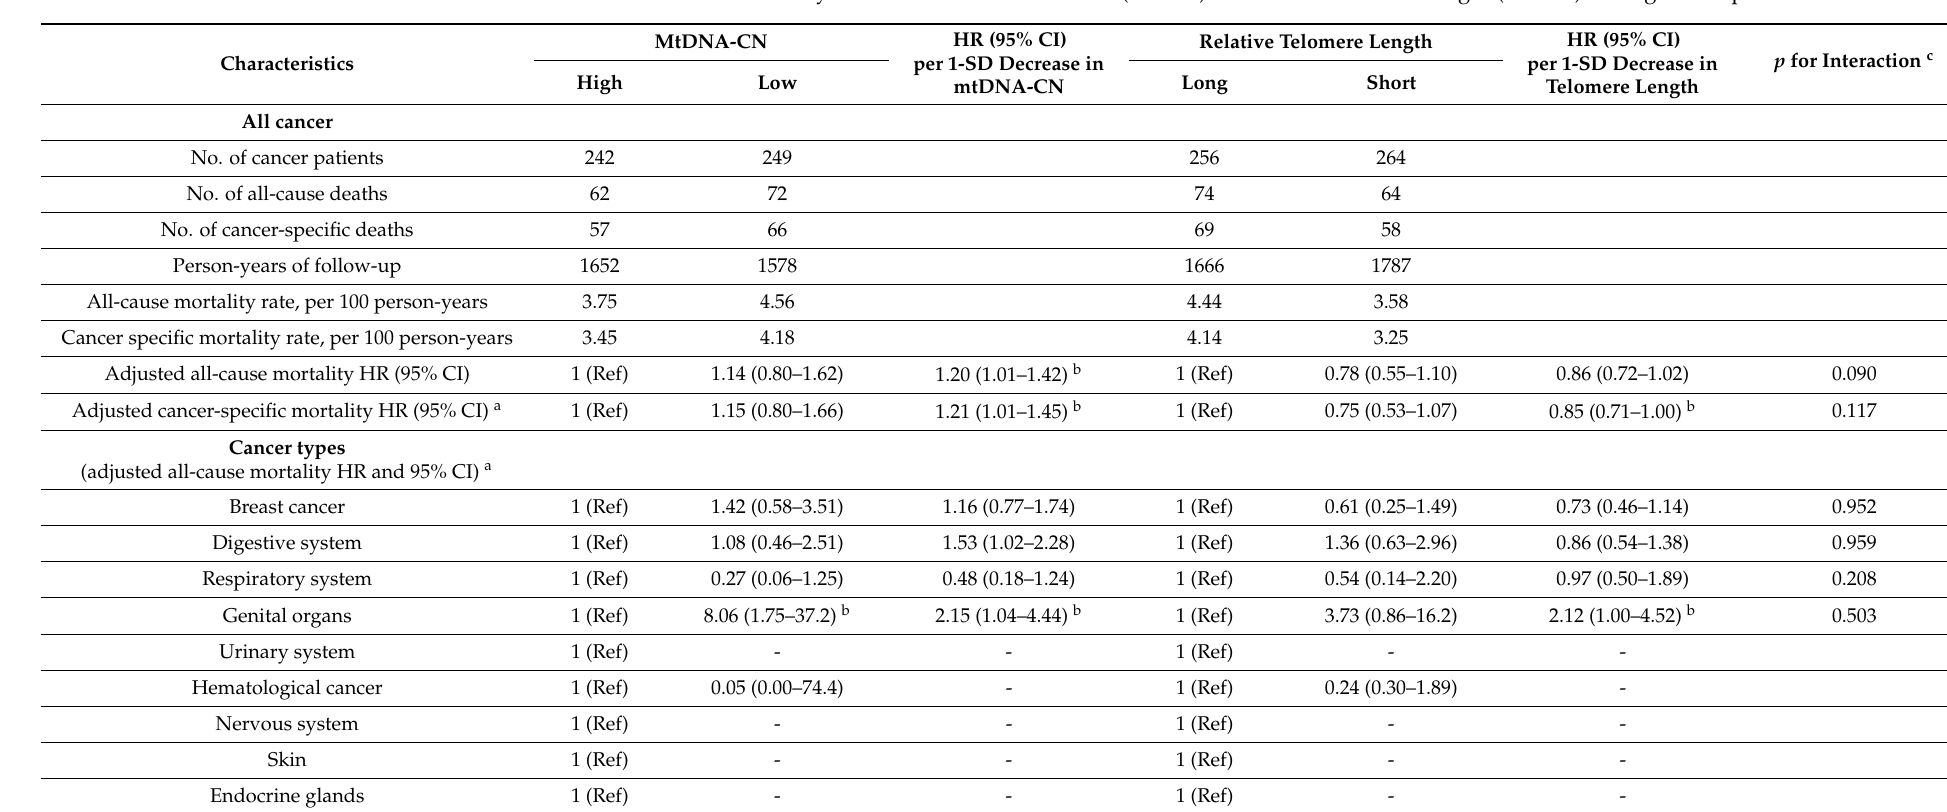
Table 5. Hazard ratios and 95% confidence intervals of mortality associated with mtDNA-CN ( n = 491) and relative telomere length ( n = 520) among cancer